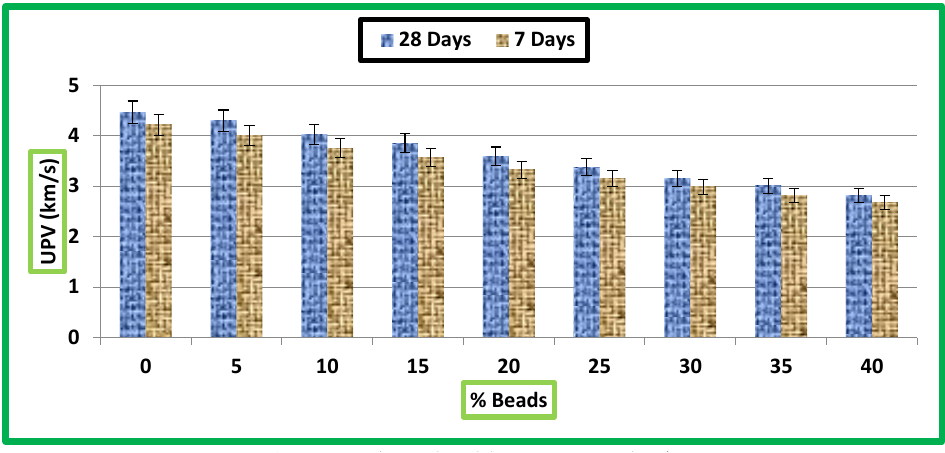
Figure 11. % Beads addition vs. UPV (km / s)